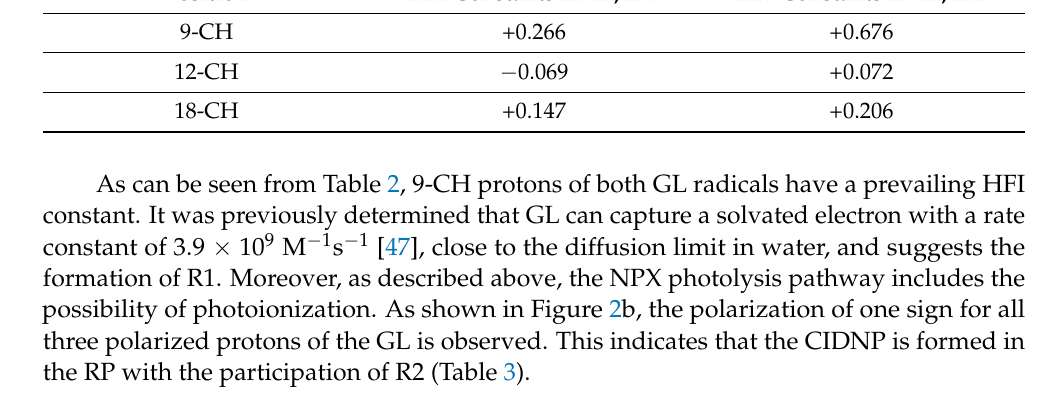
Table 3. Analysis of CIDNP signs of NPX in the presence of GL. Compound